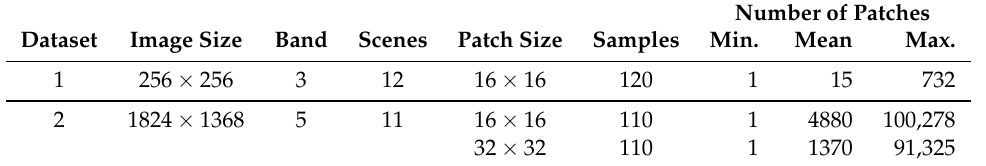
Table 5. The number of ground truth patches of size power-of-2.